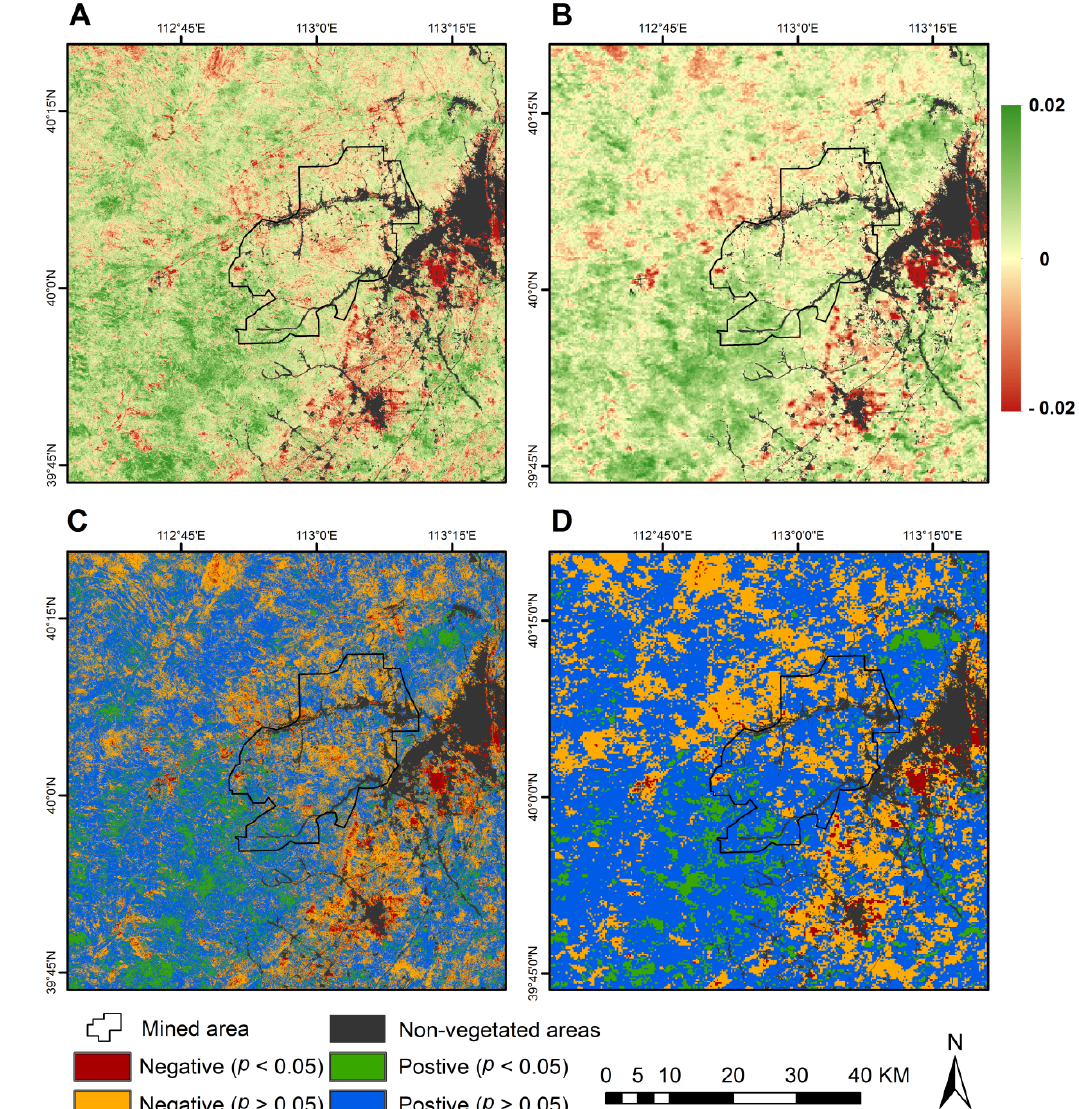
Figure 9. Spatial distribution of NDVI slopes (in NDVI units per year) derived from max ( A ) synthetic and ( B ) MODIS NDVI time series (2000–2011) and the corresponding max significance of the trends according to the Mann-Kendall test for ( C ) synthetic and ( D ) MODIS NDVI time max